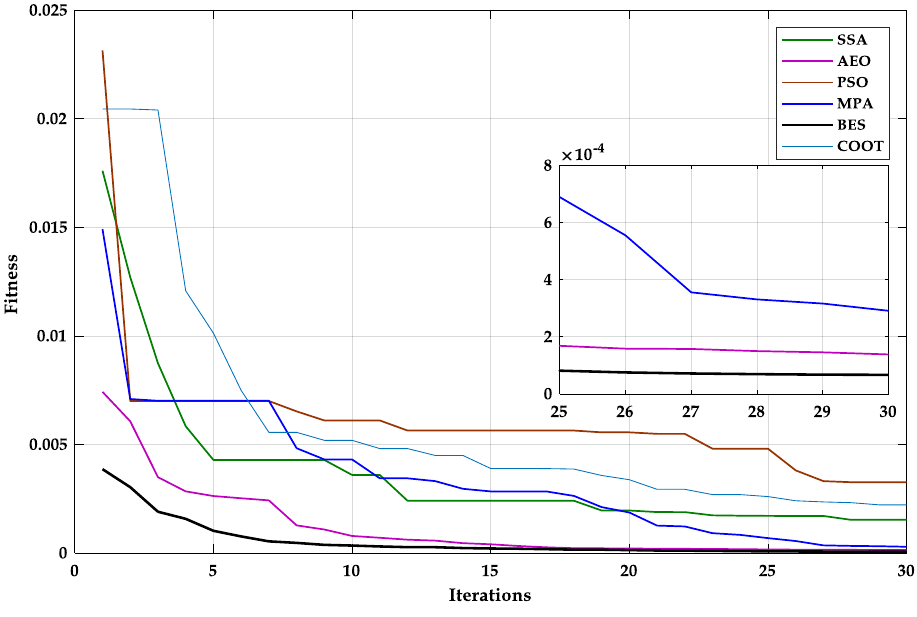
Figure 3. Mean fitness evolution.